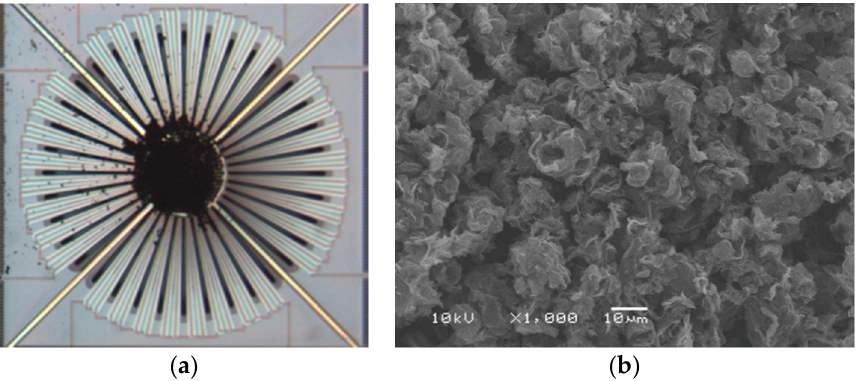
Figure 4. ( a ) The proposed CMOS-MEMS thermopile after drop-coating; ( b ) An SEM for the topology of rGO.